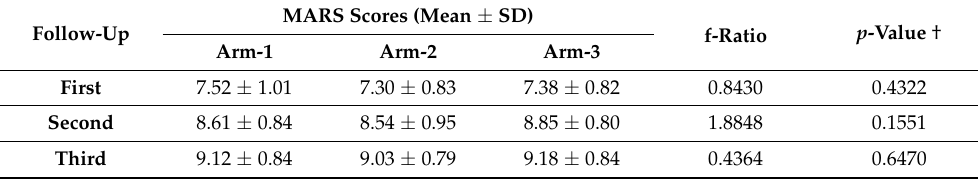
Table 2. MARS scores of different treatment arms with ANOVA test.